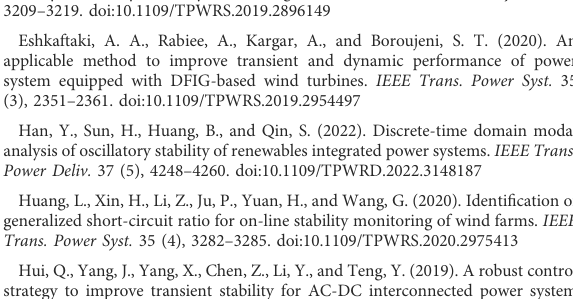
Table 2 represents the different controllers used to improve the various types of stability.